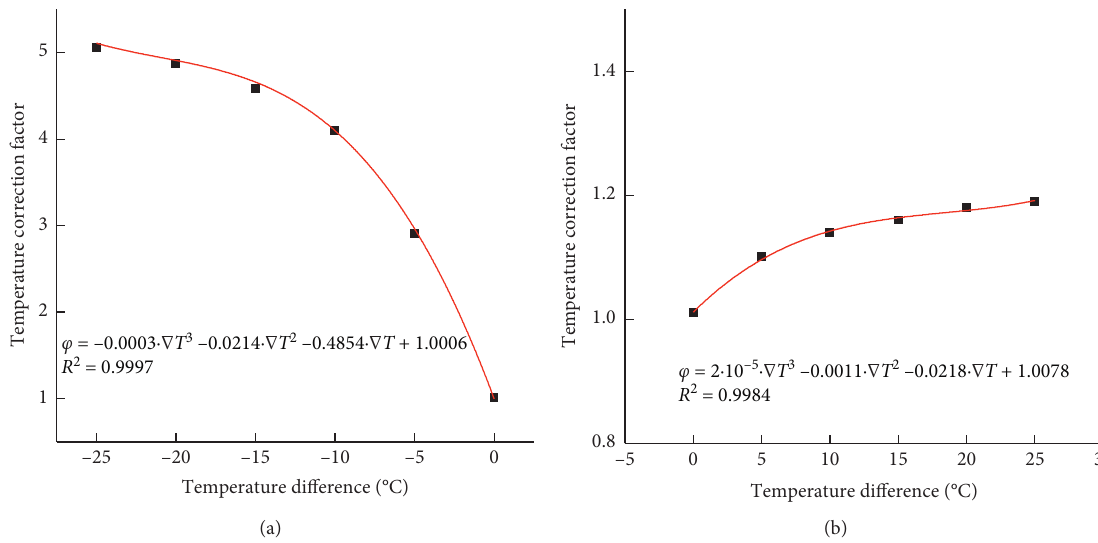
Figure 10: Correlation between positive and negative temperature differentials and correction coefficient. (a) Negative temperature range. (b) Positive temperature range.